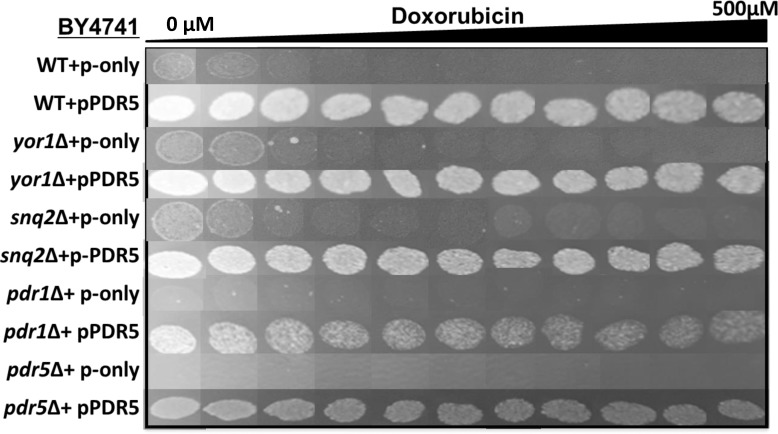

PDR5 overexpression analyses in yor1∆, snq2∆ and pdr1∆ mutants.
PDR5 gene was overexpressed in wild type, yor1Δ, snq2Δ, pdr1Δ, and pdr5Δ cells and growth rates were determined by a spotting assay in the presence of doxorubicin gradient.